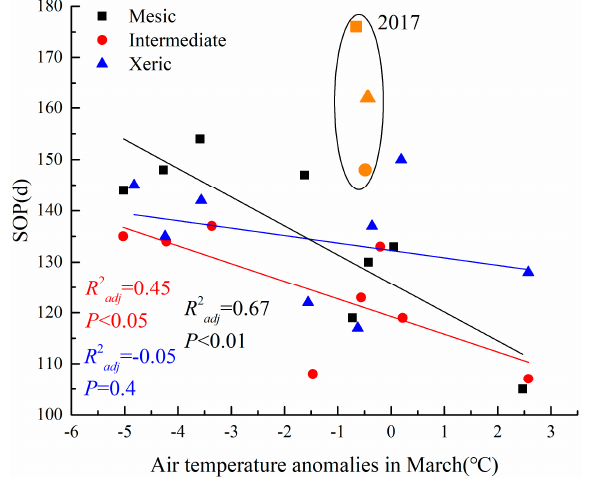
Figure 7. Sensitivity of the start of peak (SOP) to March air temperature anomalies from 2009 to 2016 by site.